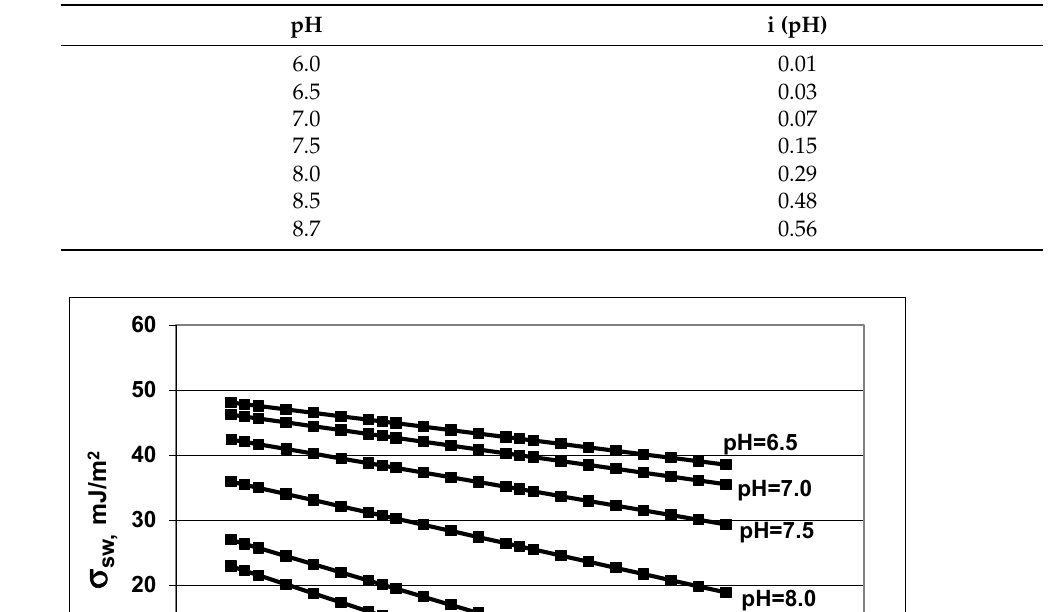
Table 3. Values of function i at different pH.